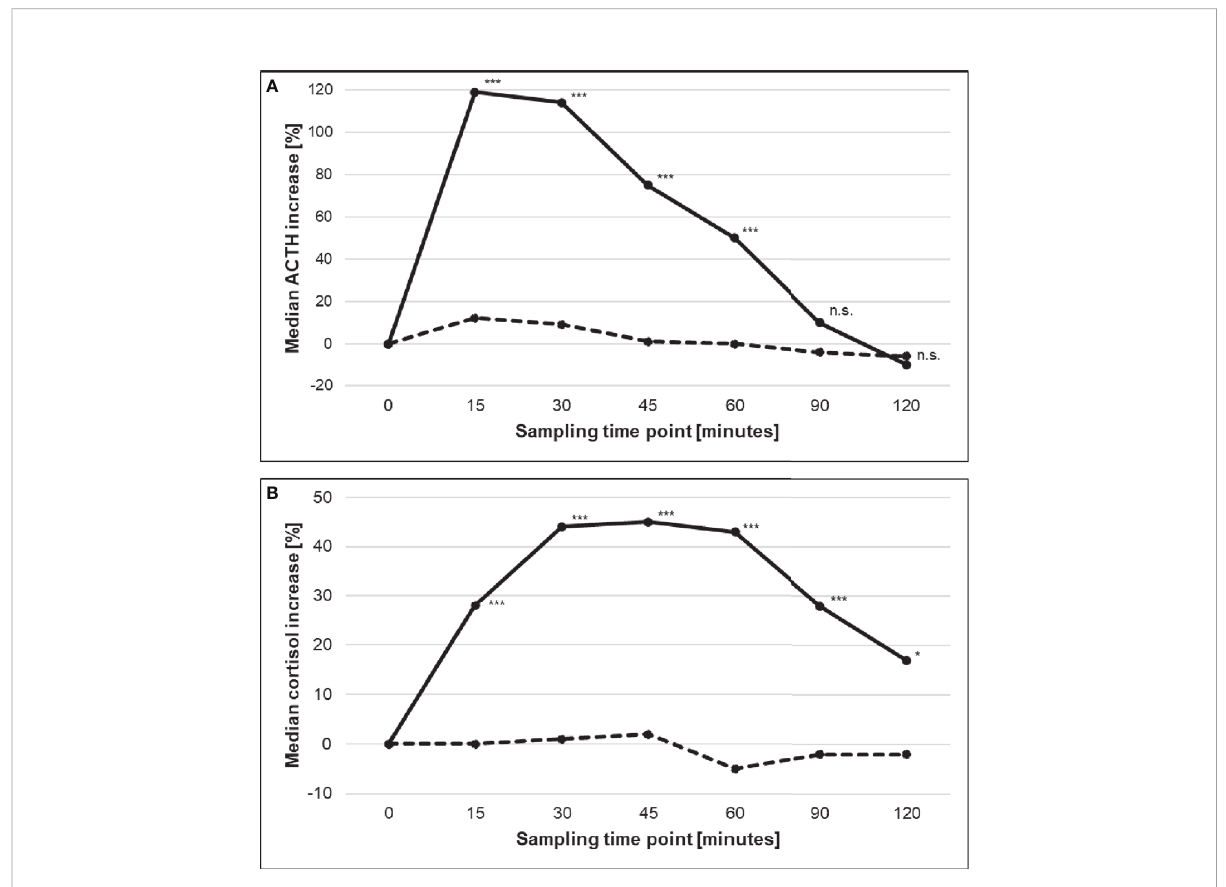
FIGURE 1 Median %-increases of (A) ACTH and (B) cortisol during the CRH stimulation test in patients with CD (solid line) and ECS (dashed line). Stars indicate statistical signi fi cant differences between both sub-entities (* <0.05; *** <0.001). ACTH, adrenocorticotropin; CD, Cushing ’ s disease; CRH, corticotropin-releasing hormone; ECS, ectopic Cushing ’ s syndrome. n.s., not signi fi